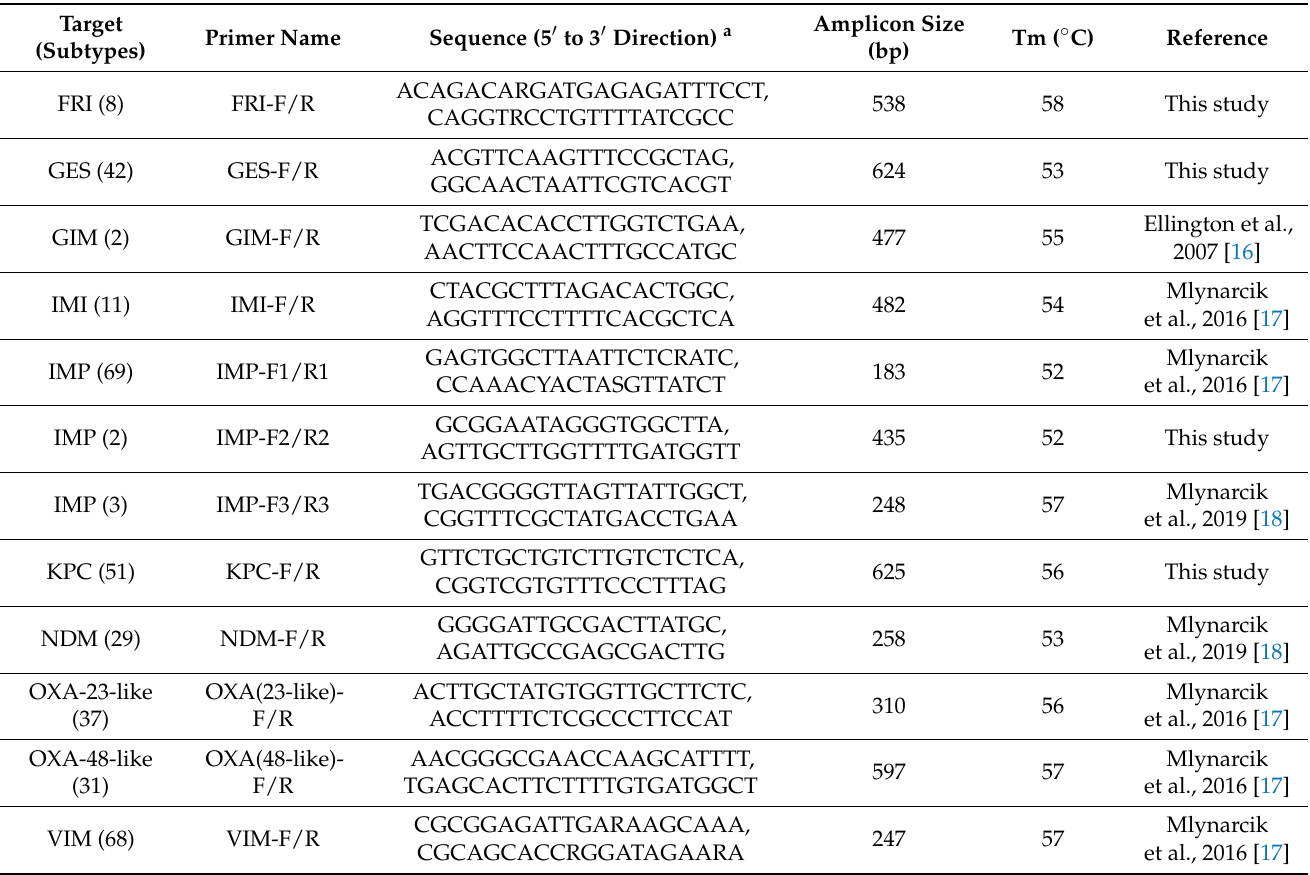
Table 2. Primer sequences used to detect the carbapenemase genes by